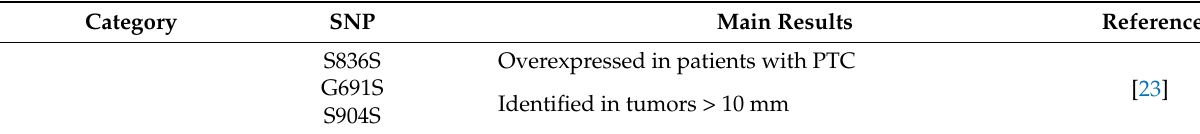
Table 1. Summary of genetic variations associated with thyroid cancer susceptibility and clinico- histopathological